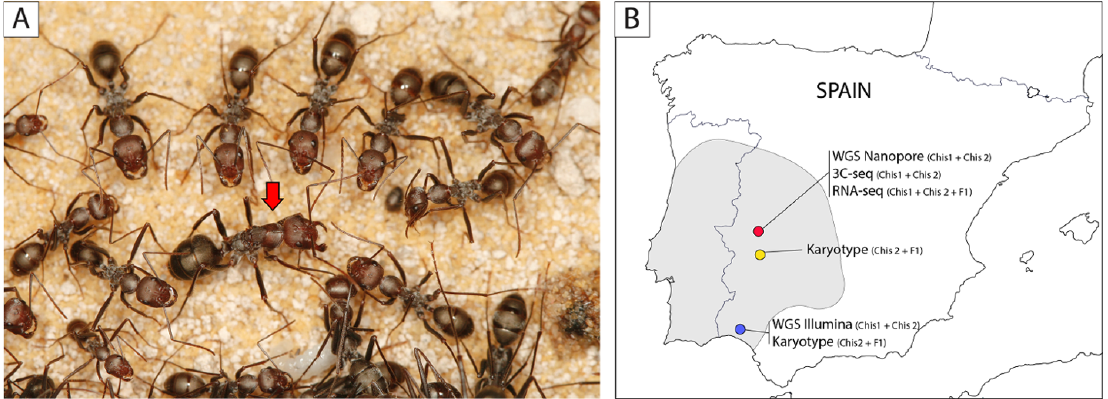
Figure 1: The ant Cataglyphis hispanica. (A) A queen of C. hispanica (red arrow) surrounded by workers. (B) Sampled sites in southwest Spain. The two interdependent lineages of the species, Chis1 and Chis2, were collected in Caceres (red), Merida (yellow) and Bonares (blue). For each lineage, a male from Bonares was used for whole-genome short-read sequencing (WGS Illumina) and queens from Caceres were used for both long-read sequencing (WGS Nanopore) and chromosome conformation capture sequencing (3C-seq). Karyotypes of two Chis2 males and three hybrid (F1) workers were obtained from Merida and Bonares. To assist gene annotation, transcriptomes (RNA-seq) were generated from